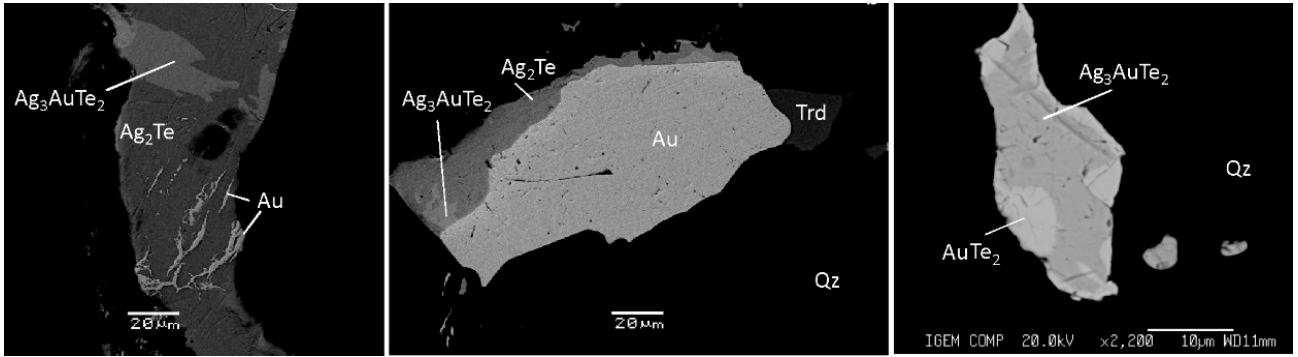
Figure 14. Au and Ag minerals in quartz veins of the Svetlinsk deposit. Qz—quartz, Trd—tetrahedrite. Many Te minerals are important carriers of Au in sulphide-bearing ore